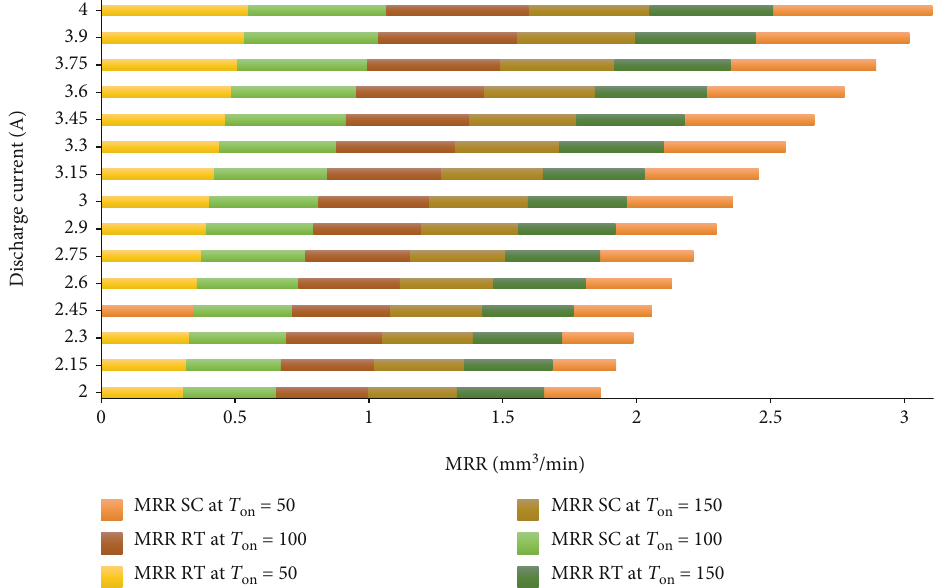
Figure 2: MRR vs. discharge current for two types of electrode at τ = 70 % .